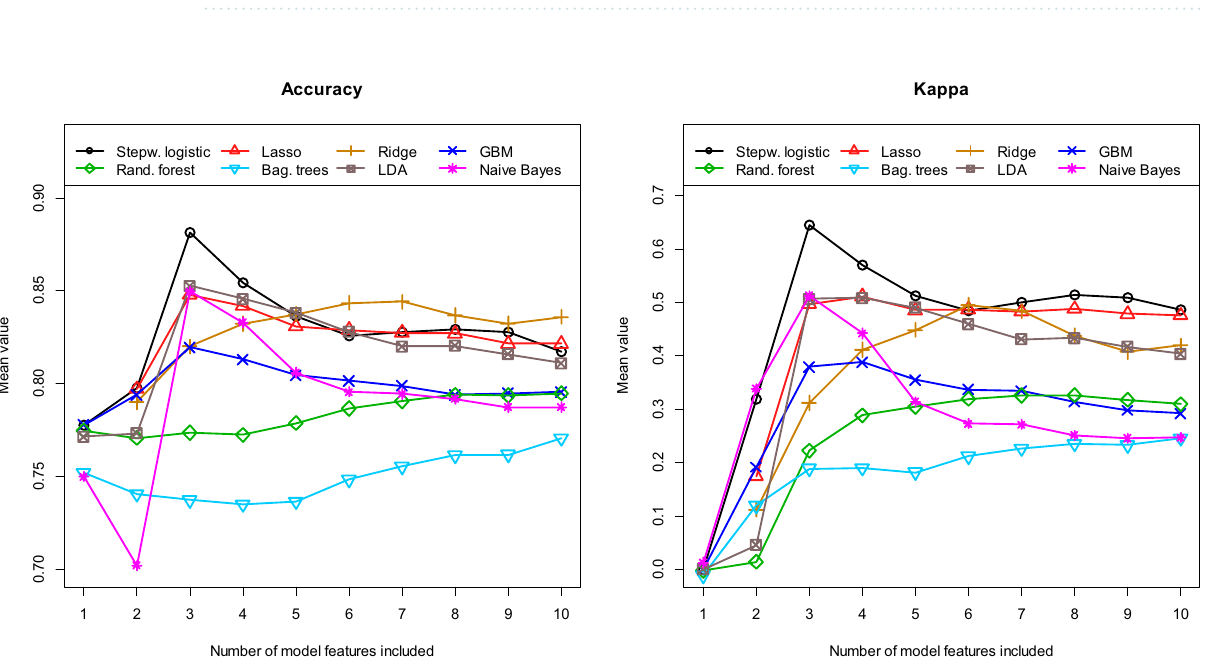
Figure 5. Accuracy and Kappa for the test samples, calculated as means of 100 repetitions (100